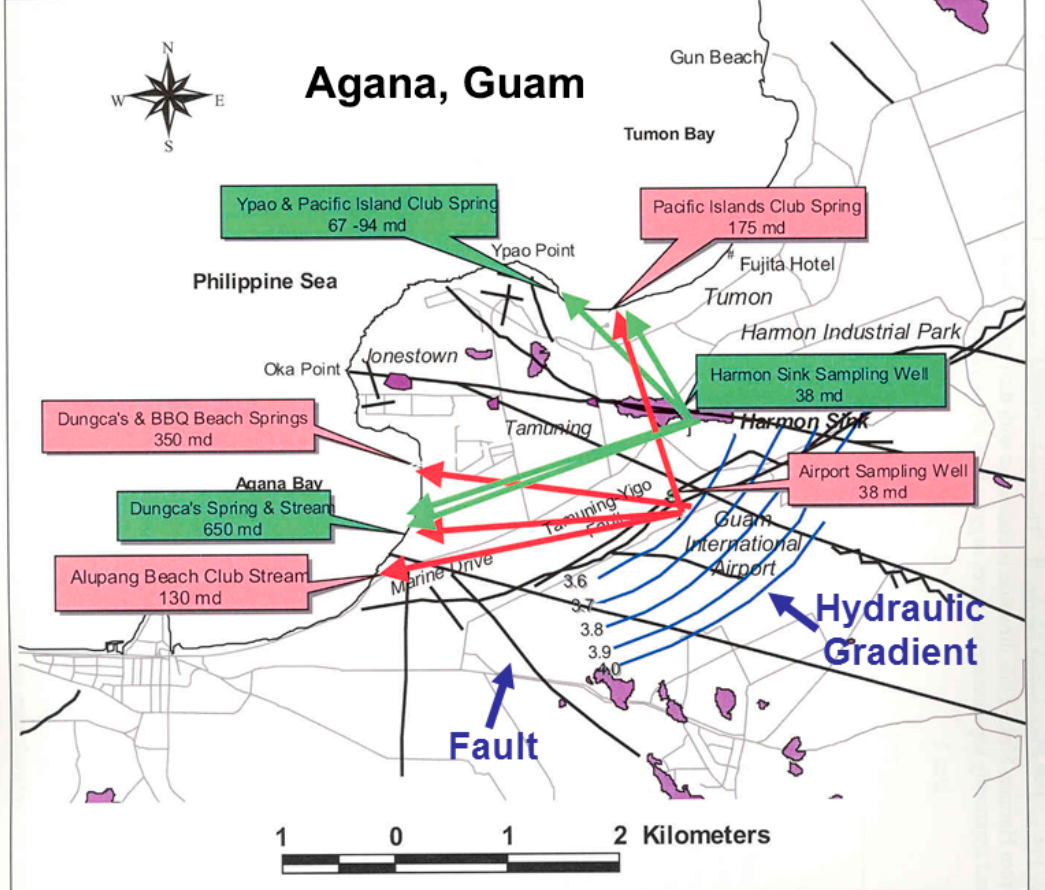
Figure 15. Map of the Agana area, Guam, modified from Moran and Jenson [38]. Flow routes and times from two separate dye traces are shown. Flow though the matrix of the eogenetic limestones displays longer transit times than flow along faults and fractures, demonstrating a dual flow system in this karst aquifer.